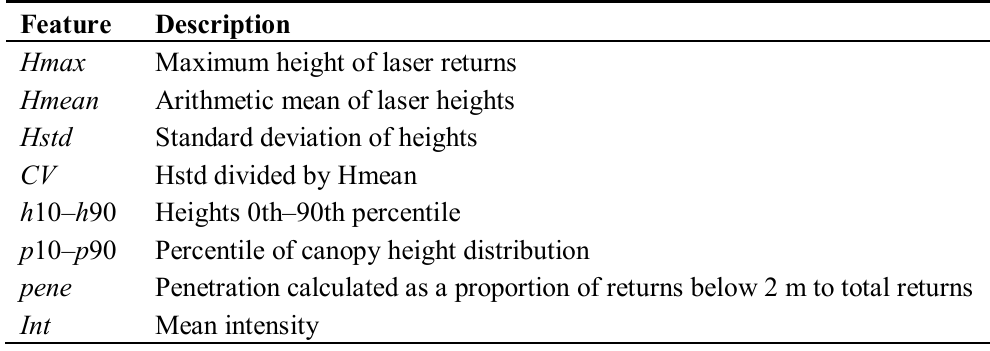
Table 3. Statistical metrics calculated from airborne laser scanning (ALS) data